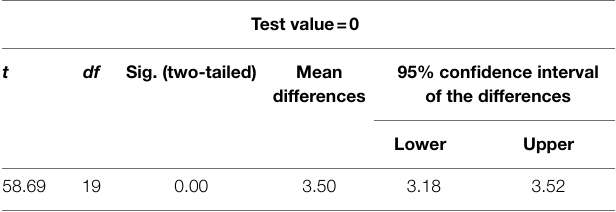
TABLE 8 | One-sample test of the MOOC questionnaire.